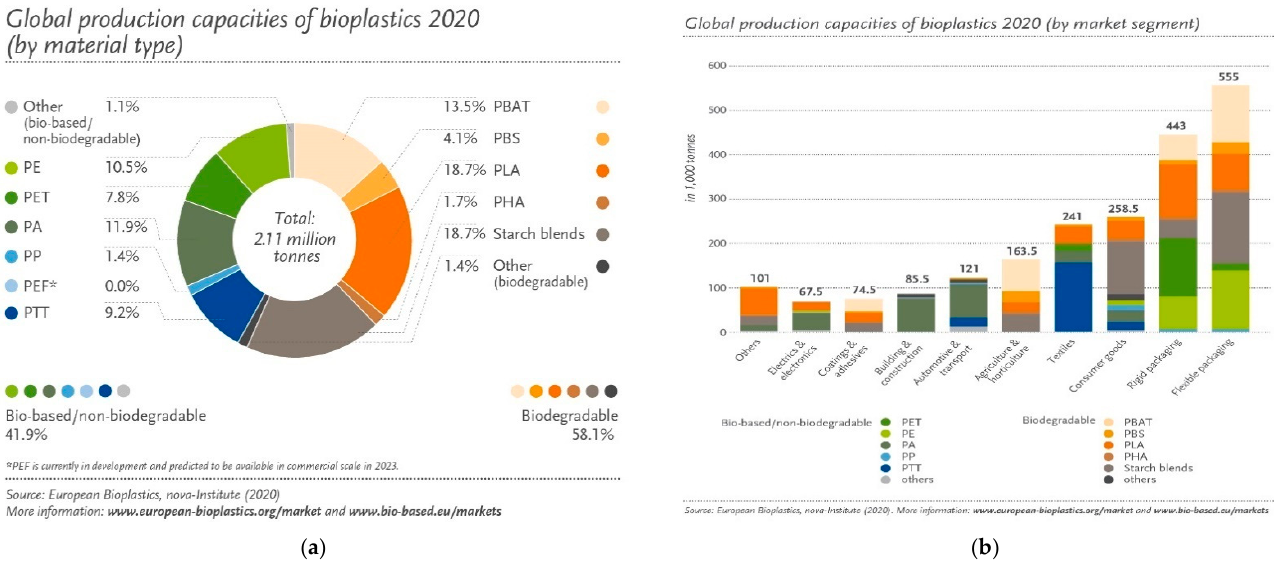
Figure 1. ( a ) Global production of bioplastics 2020 (by material type); ( b ) global production capacities of bioplastics 2020 (by market segment) (https://www.european-bioplastics.org/market/27/04/2021) [8].